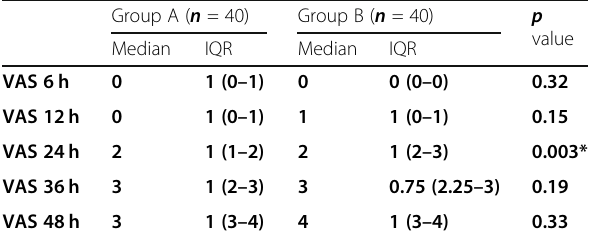
Table 5 VAS in the two study groups at movement at